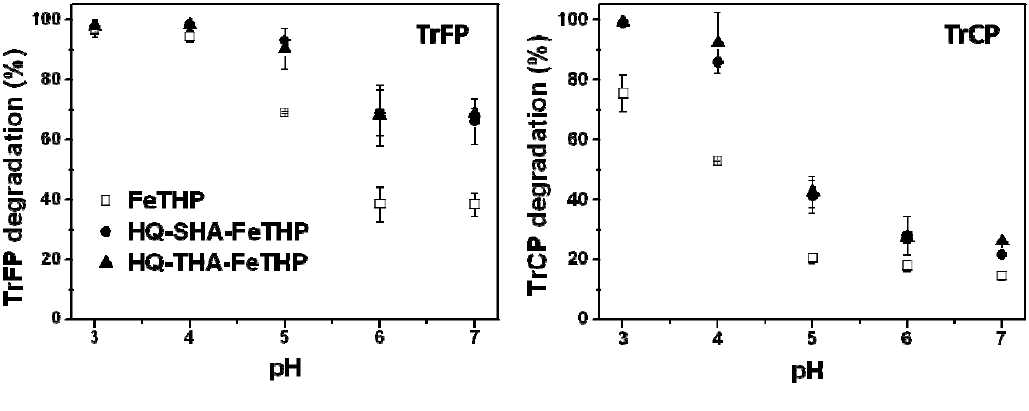
Figure 2. Influence of pH on the percent degradation of TrXP: [Catalyst] 5 μ M, [TrXP] ] 500 μ 150 μ M, [KHSO 5